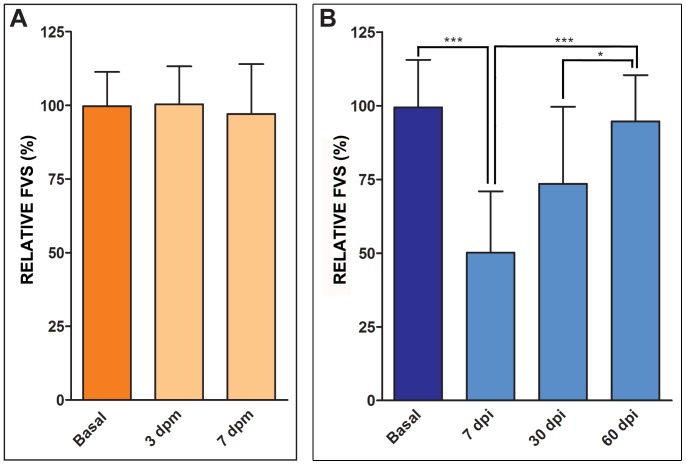
Cryoinjury transiently impairs ventricular pumping efficiency.(A,B) Temporal evolution of changes in the relative FVS in sham (A) and cryoinjured (B) animals in a longitudinal study. Graphs represent relative mean values and SD. (A) The relative FVS (RFVS) is not significantly changed in animals after sham operation at 3 (n = 14) or 7 (n = 21) dpm (p = 0.884; one-way ANOVA). (B) Cryoinjured animals show a temporal decrease in the RFVS of 50%, which is gradually recovered around 60 dpi (*** p<0.001; ** p<0.01; * p<0.05; one-way ANOVA followed by Tukey's honest significant difference test, n = 31). dpi, days postinjury; dpm, days postmanipulation; FVS, fractional volume shortening; RFVS, relative fractional volume shortening.